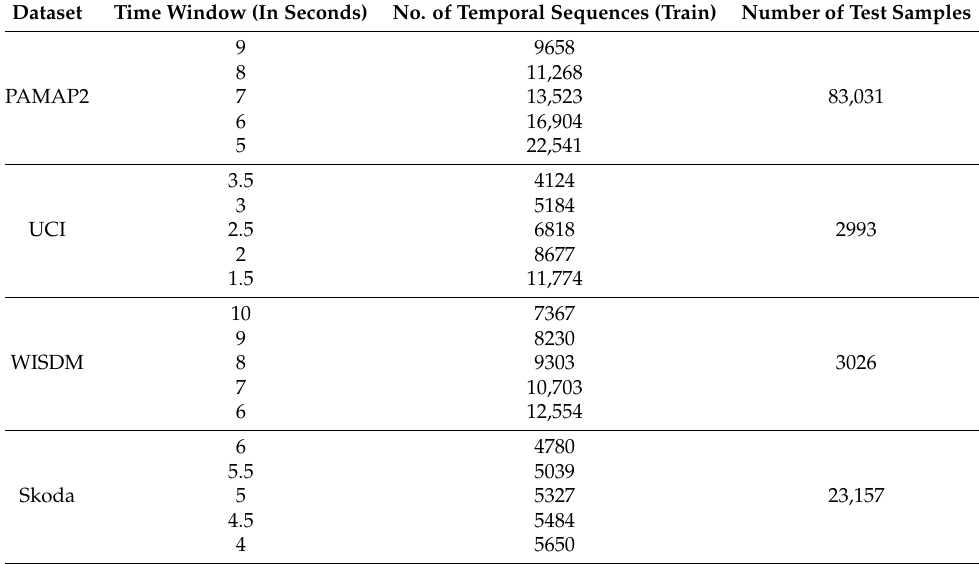
Table 2. Number of temporal sequences and labels (for training) per dataset for each model in the